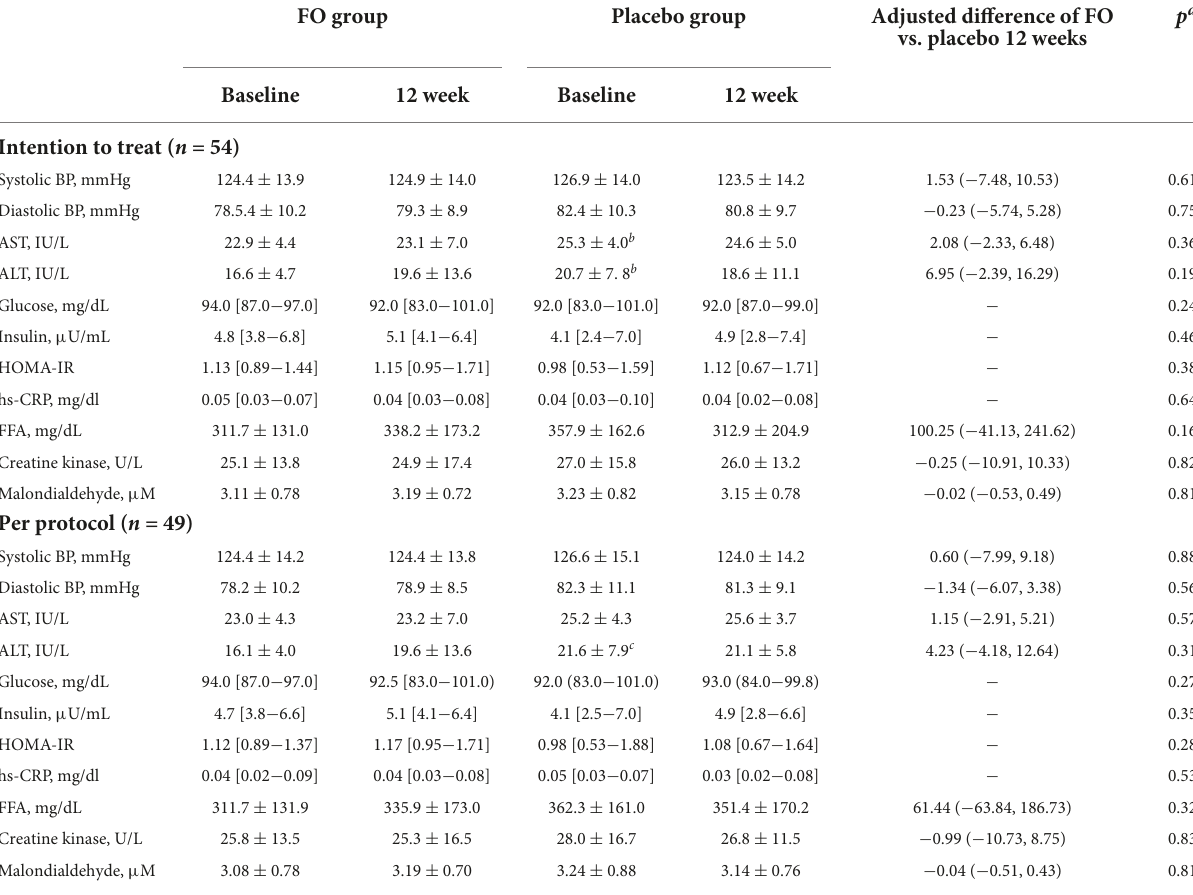
TABLE 5 Laboratory findings evaluating adverse effects and additional benefits profile. FO group Placebo group Adjusted difference of FO